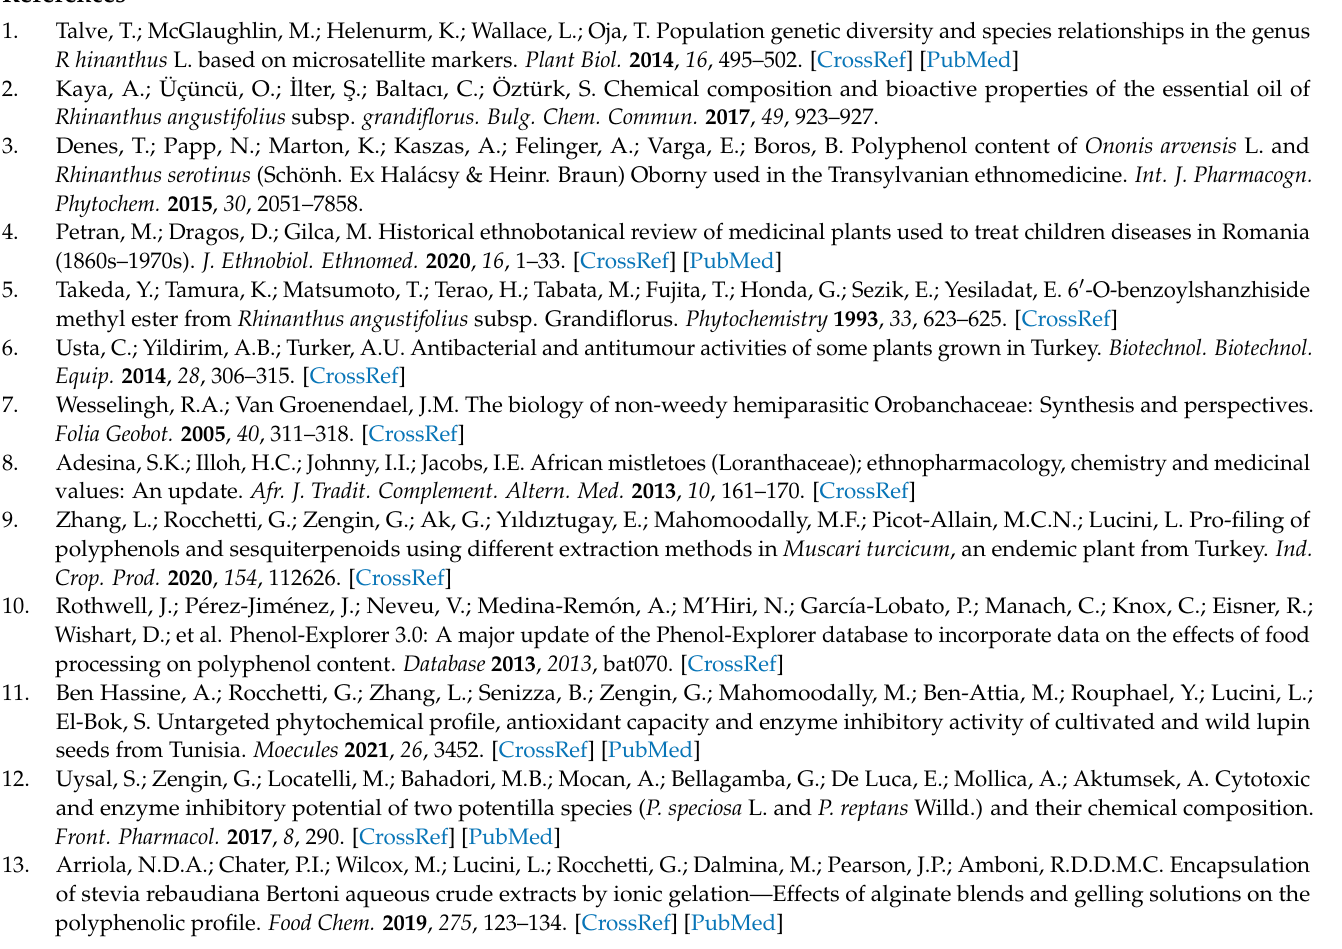
Figure S3: Permutation plots, Table S1: Dataset, Table S2: VIP markers HAE, Table S3: VIP markers MAC, Table S4: VIP markers SOX, Table S5: TBCs, Table S6: TPCs, Table S7: Pearson’s